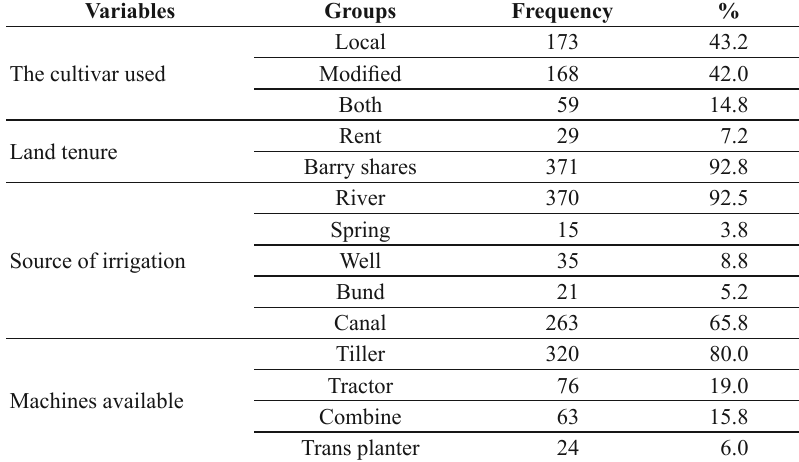
Frequency distribution of characteristics of selected agronomic variables (n = 400).